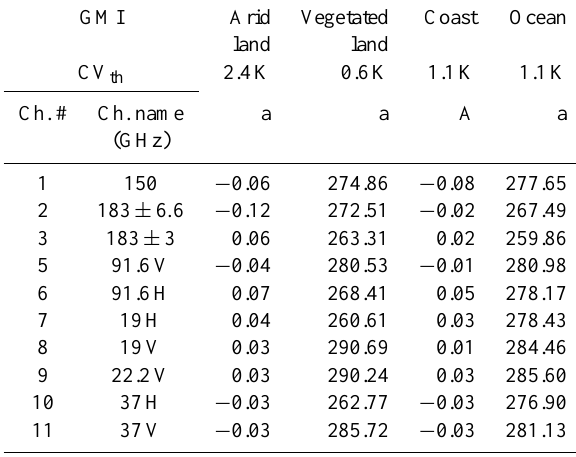
Table A2. List of CCA coefficient and CVth threshold used by the CCA algorithms for the pseudo-GMI data